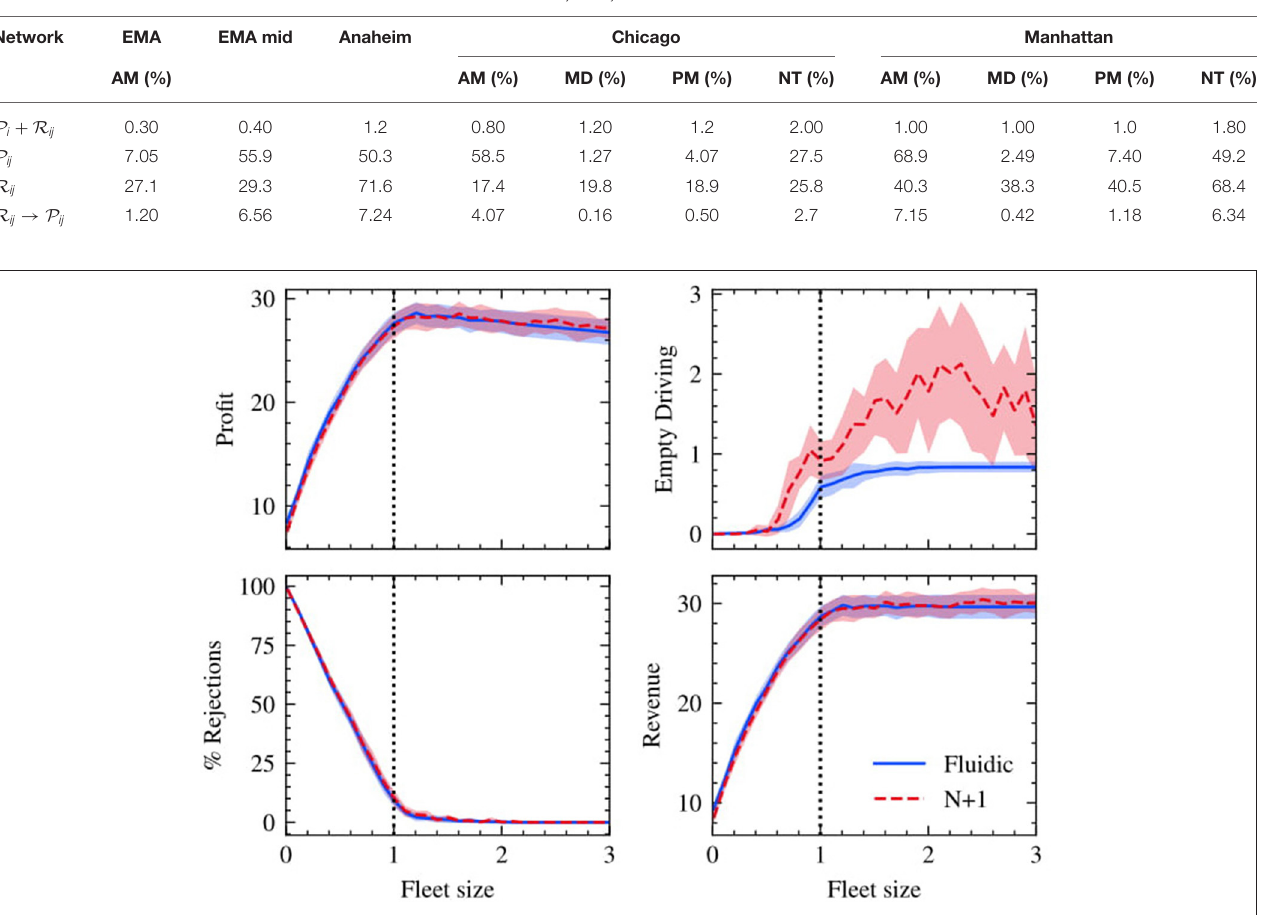
TABLE 1 | Relative deviation in of each policy compared to the joint policy P ij + R ij for different networks and time slots. Network